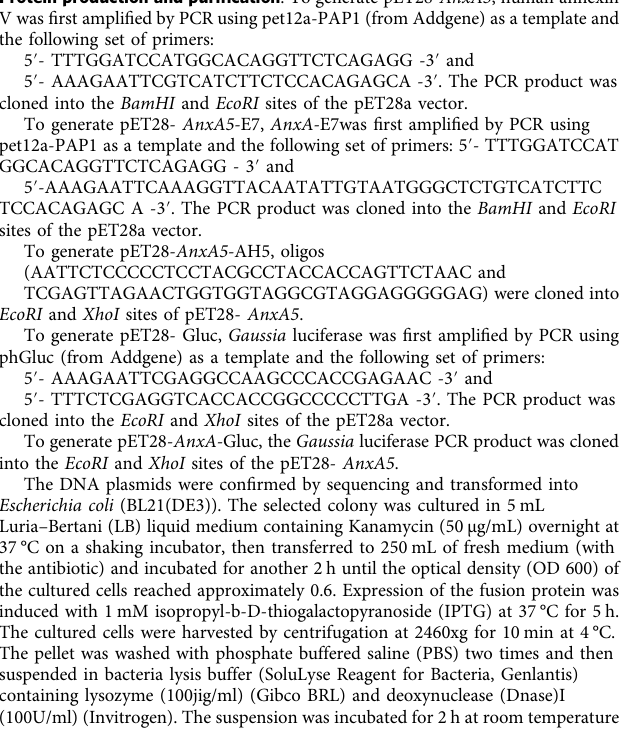
Fig. 5 Antitumor effects of recombinant Annexin A5-E7 fusion protein. C57BL/6 mice were injected with 2 × 10 5 TC-1 cells/mouse subcutaneously on day 0. Mice were then treated intraperitoneally with 5 mg/kg Cisplatin on days 12 and 15, intravenously with 200jig/mice of Annexin A5-E7 fusion protein, 200jig/mice of Annexin A5 proteins, and/or 3.5jig/mice of E7 long peptide on days 13, 14, 16, and 17. The treatment groups are as follows: opened triangle — PBS only; closed triangle — cisplatin only; opened square — E7 peptide only; closed square — cisplatin and E7 peptide; opened sphere — Annexin A5 only; closed sphere — cisplatin and Annexin A5; opened circle — Annexin A5-E7peptide only; closed circle — cisplatin and Annexin A5-E7 peptide. a Schematic diagram. b Line graph depicting TC-1 tumor growth in different treatment groups over time ( n = 10). P -values were determined by one-way ANOVA